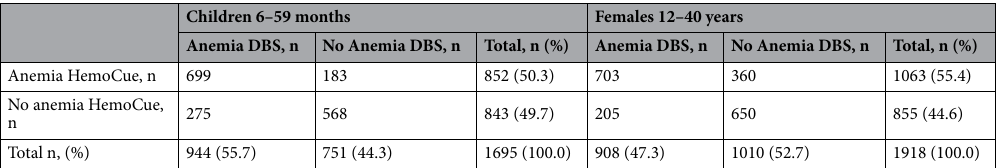
Table 5. Anemia classification a by HemoCue and DBS, children 6–59 months and females 12–40 years. a Anemia is classified as Hb concentration < 11.0 g/dL for children and < 12.0 g/dL for females.